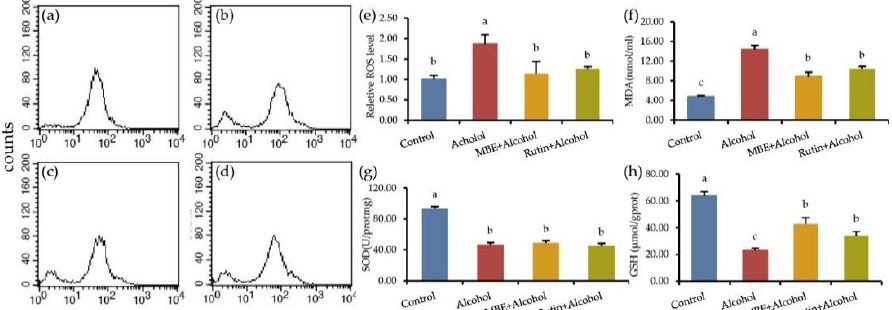
Figure 3. MBE and rutin can improve the antioxidant capacity of GES-1 cells. Panels ( a – d ) representative histogram of ROS analysis: ( a ) Control; ( b ) Alcohol, after treatment with 500 mM alcohol for 4 h; ( c ) MBE + Alcohol, GES-1 cells were pretreated with 400 µ g/mL MBE for 24 h, then treat it with 500 mM alcohol for 4 h; ( d ) Rutin + Alcohol, GES-1 cells were pretreated with 320 µ M rutin for 24 h, then treat it with 500 mM alcohol for 4 h; ( e ) the quantitative data of ROS in alcohol-damaged GES-1 cells; ( f ) effect of MBE and rutin on MDA in alcohol-damaged GES-1 cells; ( g ) effect of MBE and rutin on SOD in alcohol-damaged GES-1 cells; ( h ) effect of MBE and rutin on GSH in alcohol-damaged GES-1 cells. Different letters indicating significant differences labeled at the inhibitory activity at different compounds ( p < 0.05).